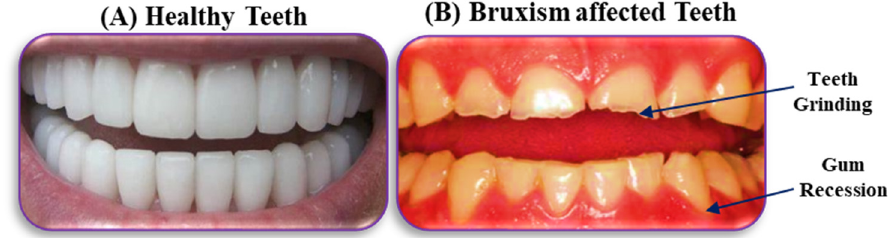
Figure 1. Comparison between ( A ) healthy and ( B ) bruxism teeth of the human. The grinding of the tooth is shown in the case of bruxism.